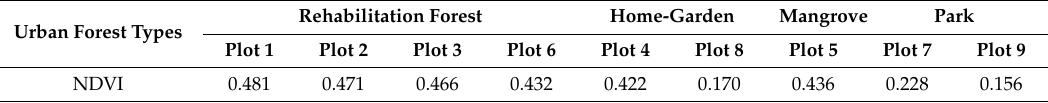
Table 3. NDVI values for Bang Kachao Green Space study plots.